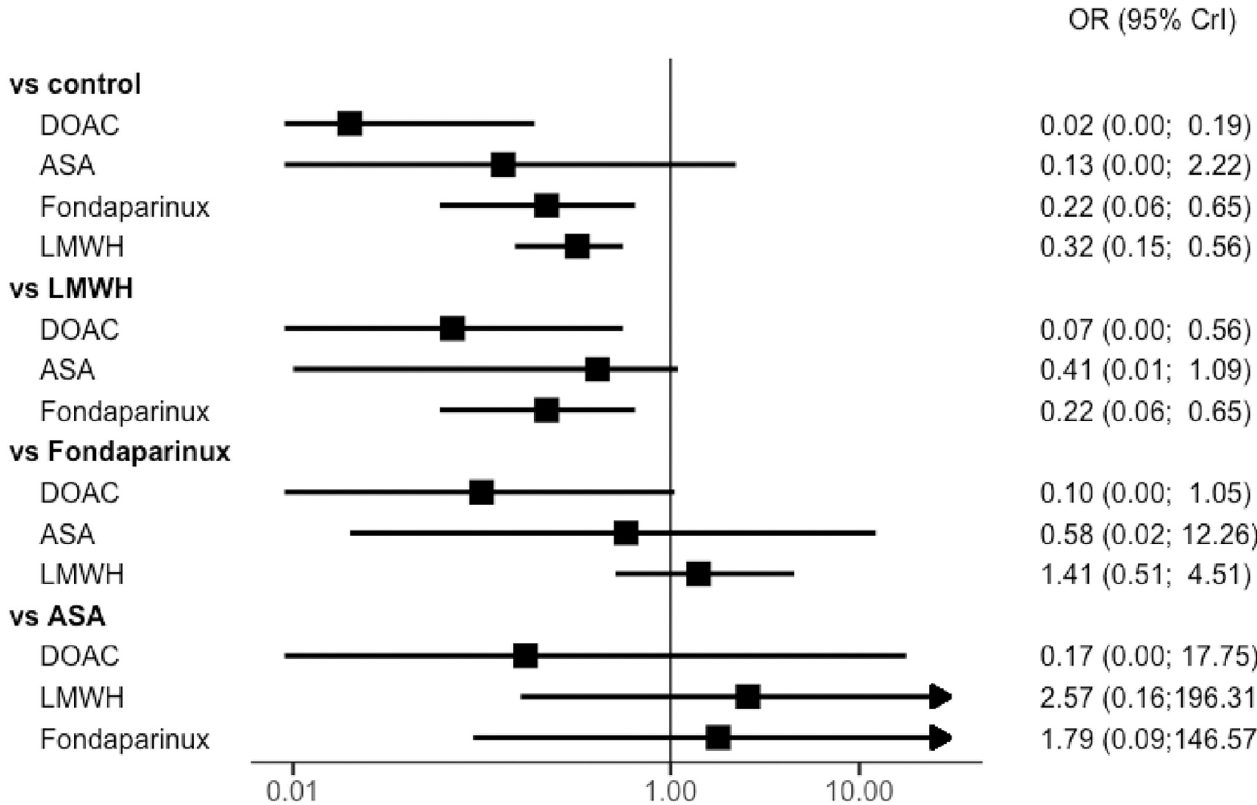
Fig 3. Network forest plot for the primary outcome (major VTE) in all RCTs with OR (points) and their 95% CrIs (lines). ASA AU : AbbreviationlistshavebeencompiledforthoseusedinFigs 3 (cid:0) 6 : Pleaseverifythatallentriesarecorrect : , aspirin; DOAC, direct oral anticoagulant; LMWH, low molecular weight heparin; OR, odds ratio; RCT, randomized controlled trial; VTE, venous thromboembolism; 95% CrI, 95% credible